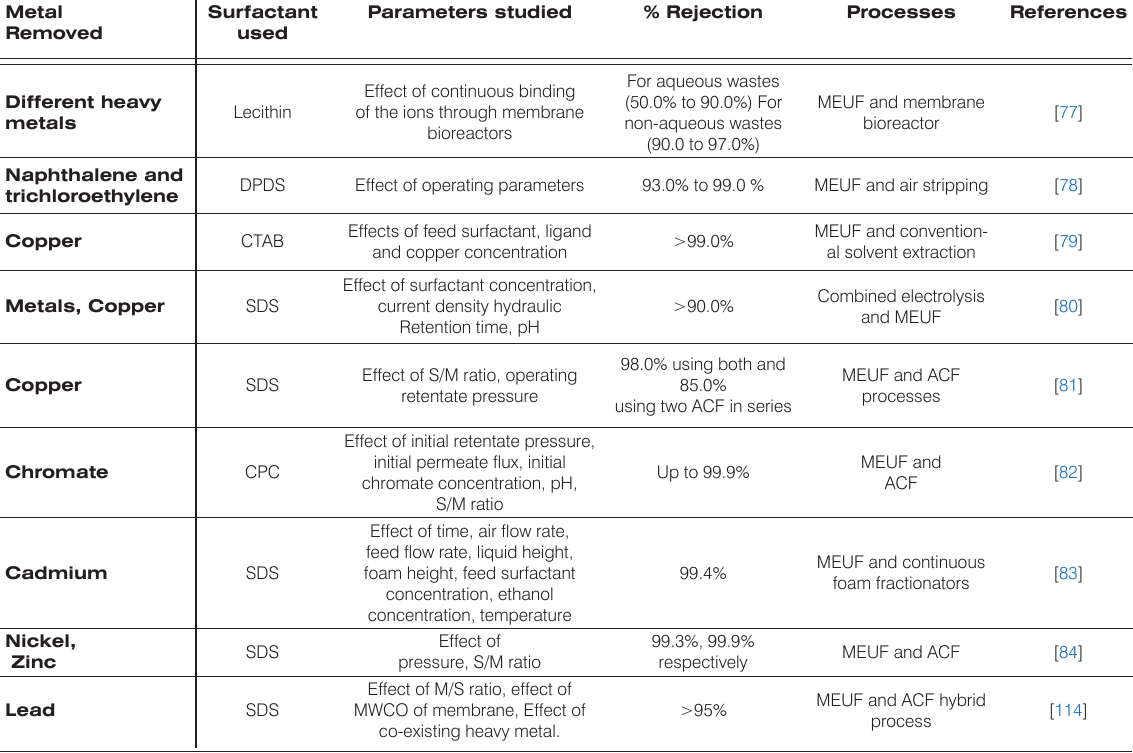
Table 5. Combination of MEUF and other